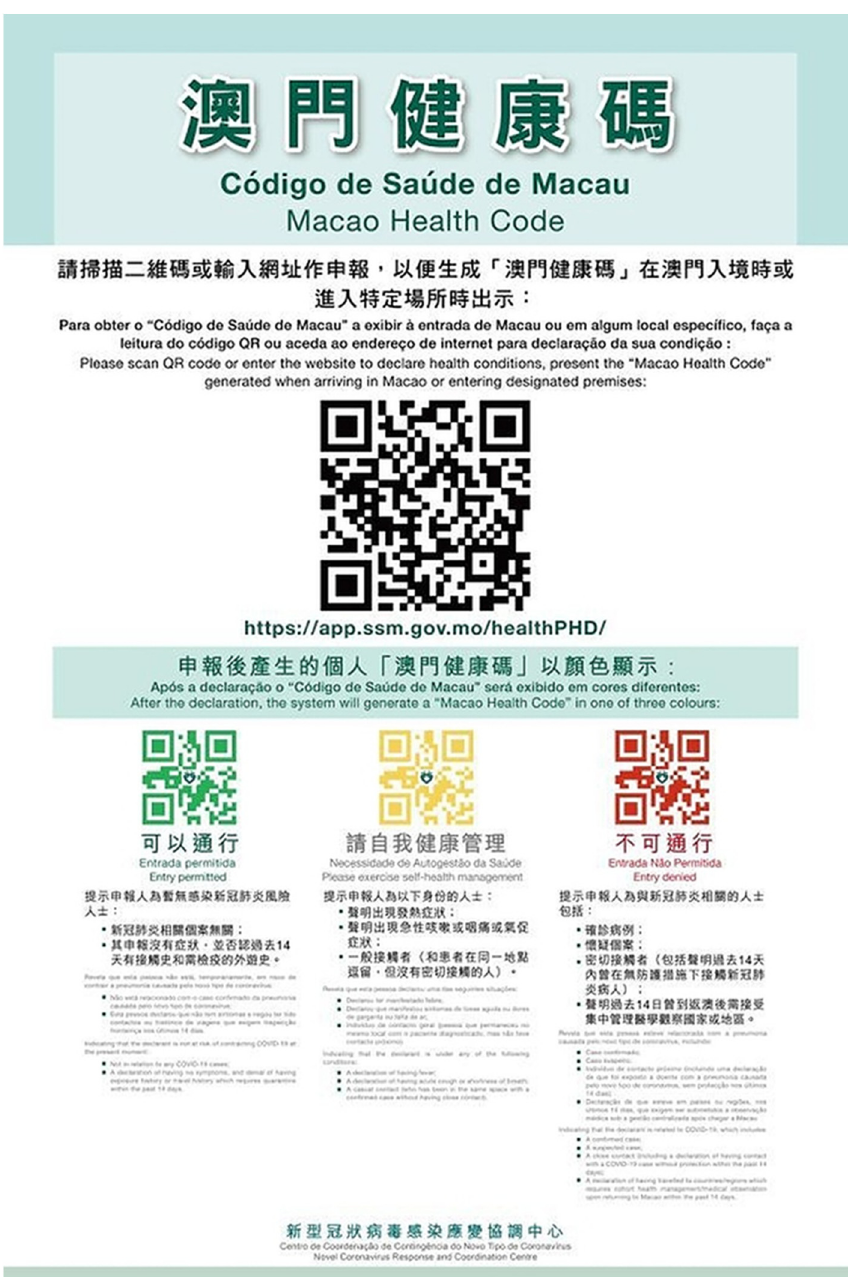
Figure 13. An example of health code in Macao, China [193].